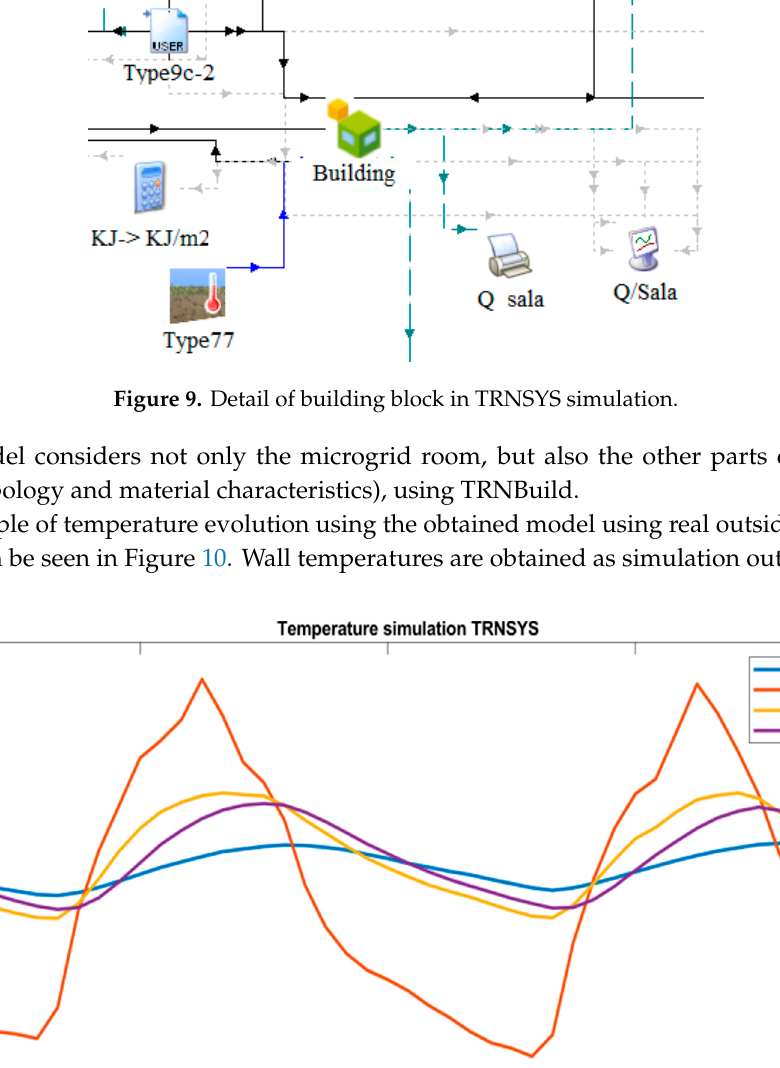
Figure 10. Phase deviation between temperatures.